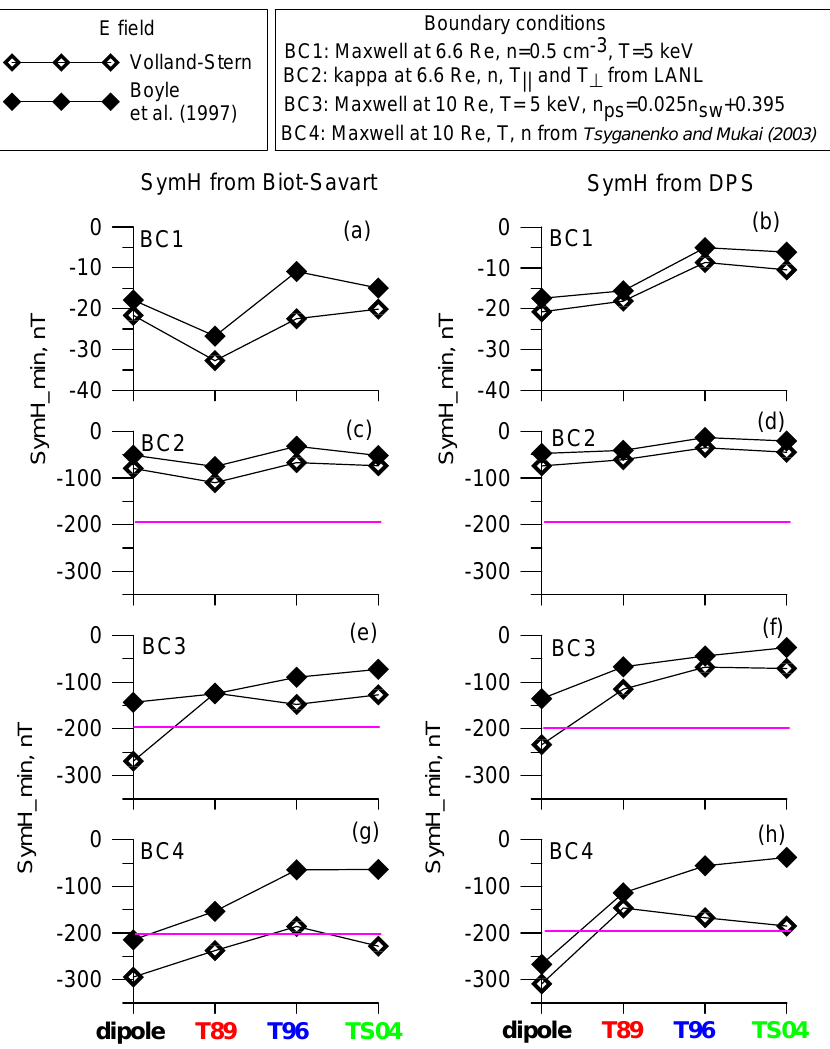
Fig. 13. Minimum SymH* values of the modeled SymH* profiles shown in Figs. 10 and 11 during 21–22 October 1999 storm. Purple horizontal lines mark the observed SymH* minimum